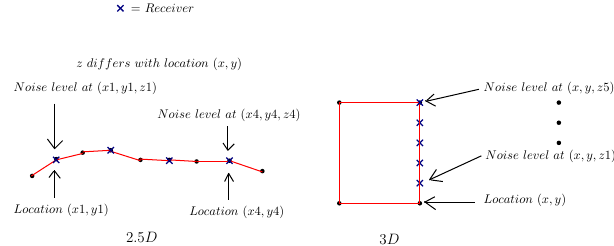
Figure 2: Noise mapping in 2D (left) and 3D (right)